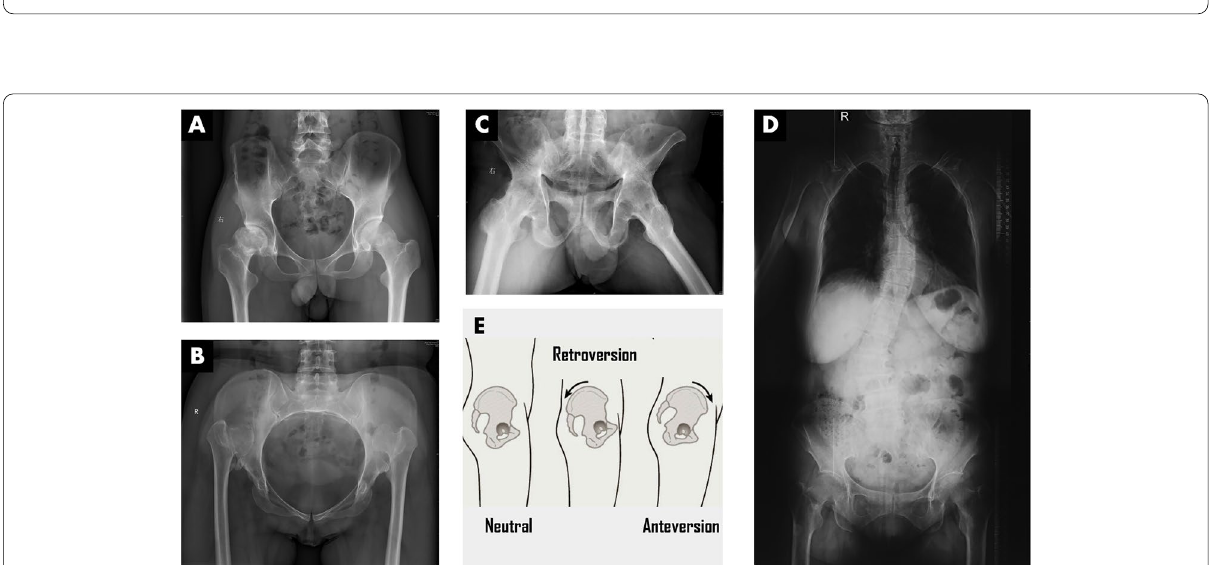
Fig. 3 Anteroposterior view of a pelvic X-ray is a mirror reflecting different condition of hip-spine complex. A Bilateral femoral avascular necrosis with a normal pelvis orientation and physiological hip-spine relation, which constitutes low risk in THA. B Bilateral hip dislocation and osteoarthritis resulted from DDH with an extremely anteverted pelvis and hypermobile hip-spine relation, which constitutes high risks of instability, dislocation and mechanical loosening in THA. C Hip involvement of ankylosing spondylitis with an extremely retroverted pelvis and stiff hip-spine relation, which constitutes high risk of impingement, wear failure, and dislocation in THA. D Hip osteoarthritis secondary to degenerative lumbar disease with moderately retroverted pelvis and stiff hip-spine relation, which constitutes high risk of impingement, dislocation and abnormal gait in THA. E An illustrative manifestation of pelvis in lateral view showing neutral, retroverted and anteverted pelvis in above hip